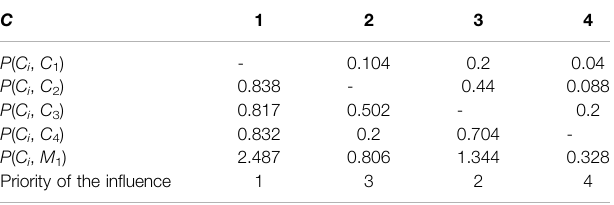
TABLE 1 | The change impact degrees of parts within M 1 .